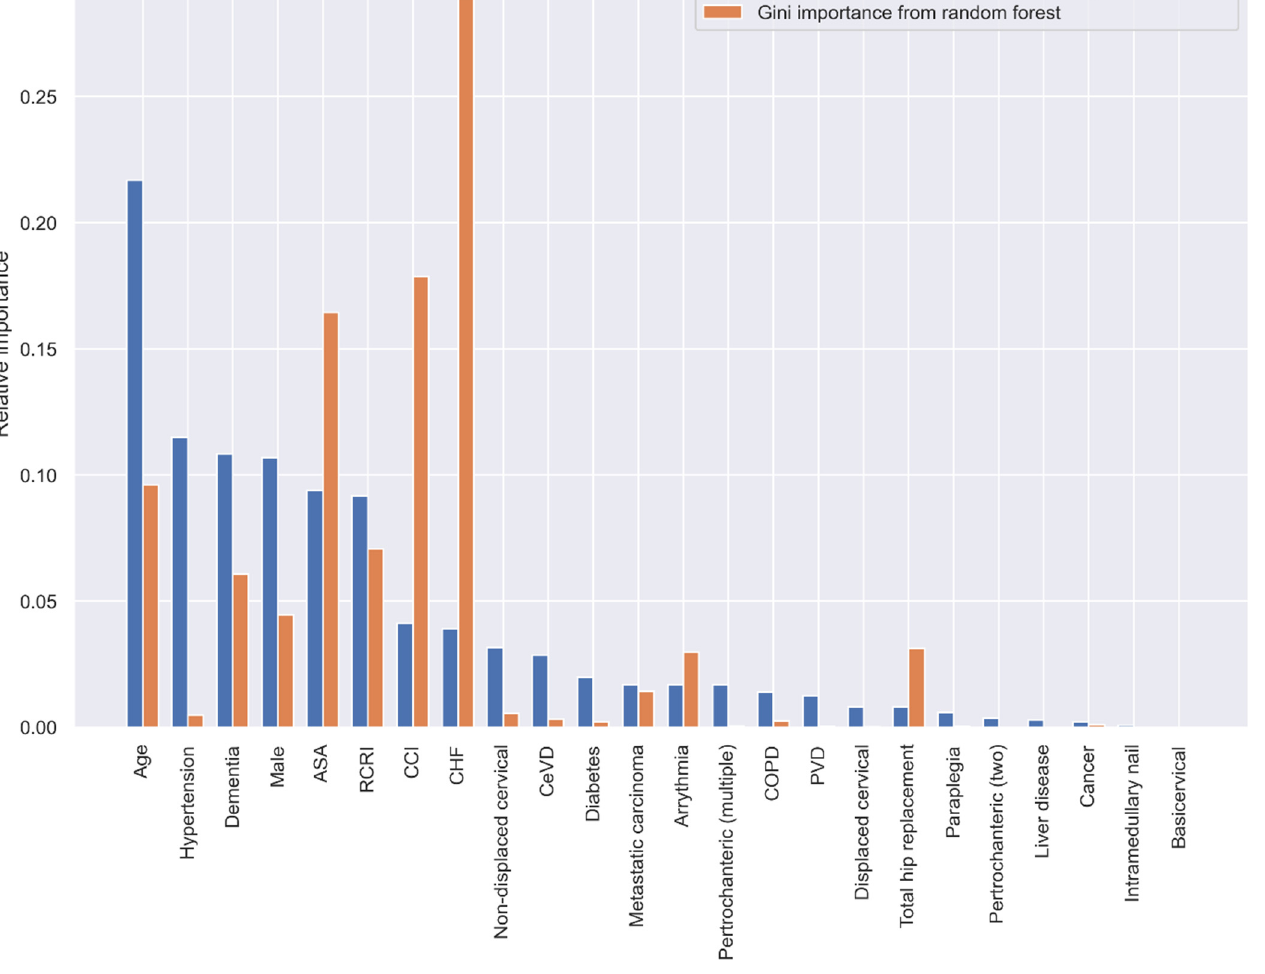
Figure 4. Relative variable importance in prediction 30-day mortality (variables selected by the stepwise LR analysis).